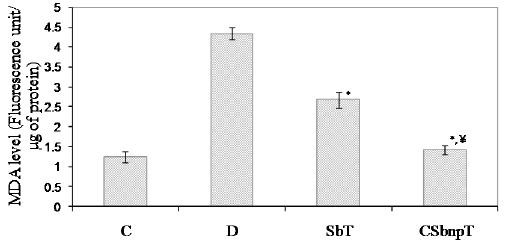
Figure 7. Effect of Sb and CSbnp treatment on serum MDA level in rats. C- control group, D – diabetic group, SbT – Sb treated group, CSbnpT – CSbnp treated group. Results were expressed as mean 6 SD (n=6). *P , 0.001 highly significant difference compared with D group. ¥ P , 0.001 highly significant difference compared amongst Sb and CSbnp treated